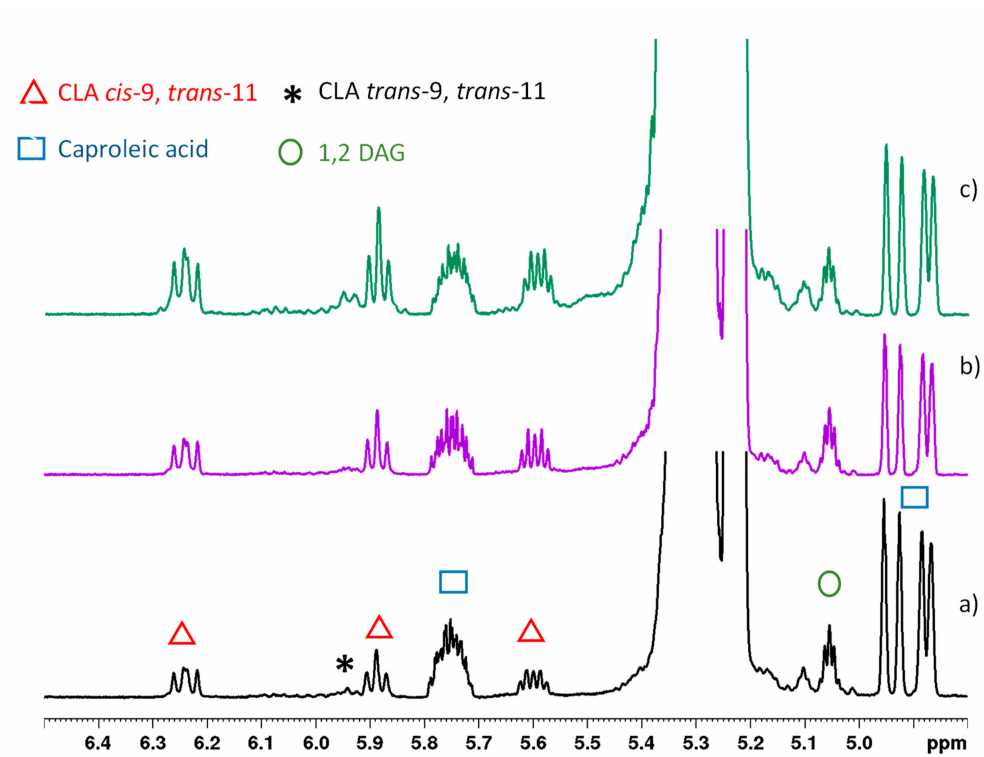
Figure 2. Expanded region of 600 MHz 1 H spectra of goat milk lipid fraction from ( a ) control, ( b ) hempseed, and ( c ) linseed diets in CDCl 3 at 298 K. Resonances highlighted with symbols show changes due to